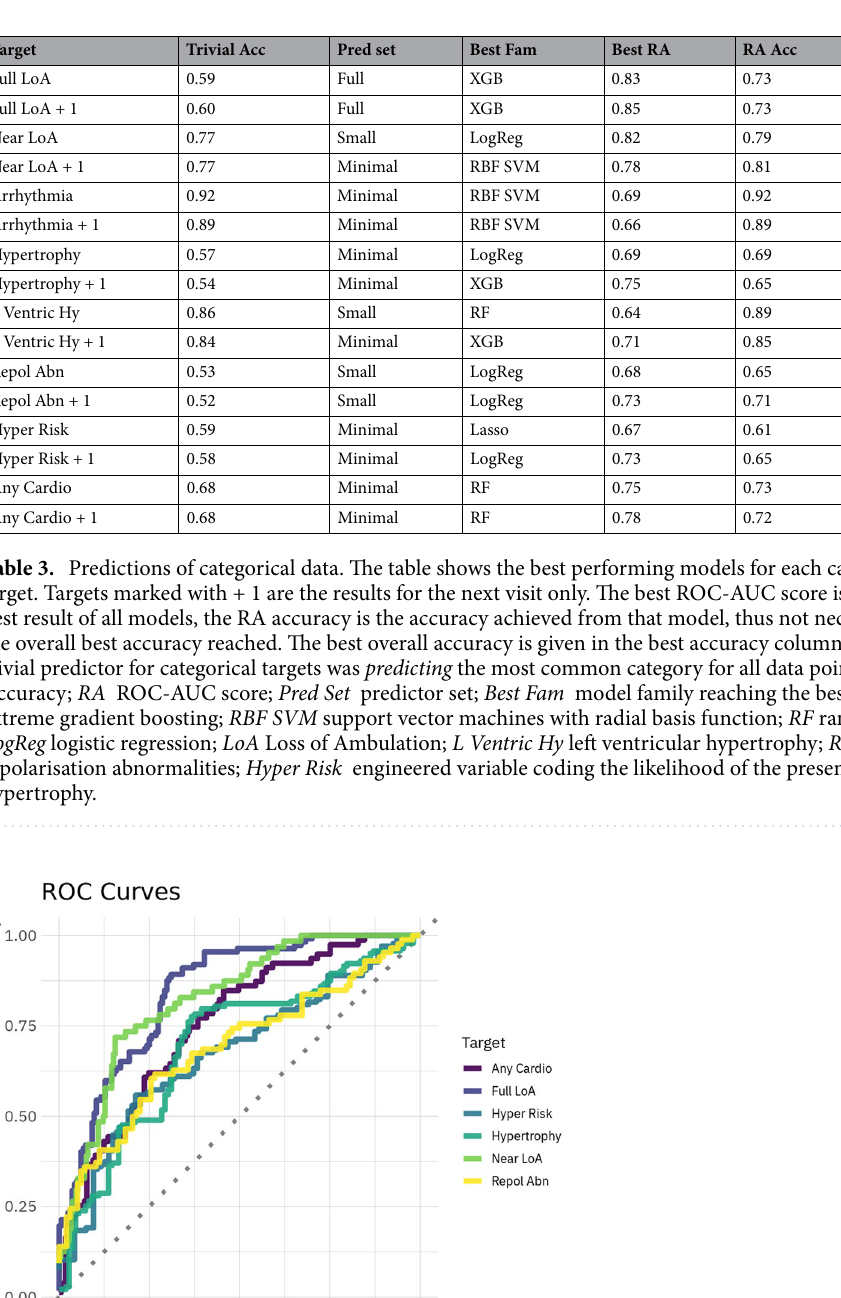
As for full loss of ambulation ROC-AUC scores where between 0.68 and 0.84, the best model having an accu- racy of 0.74 compared to the trivial classifier with 0.59. Regarding predictions for full loss of ambulation at the next visit, performance was largely similar with the model’s ROC-AUC score being 0.85, achieving an accuracy of 0.73, while the baseline was an accuracy of 0.60. Finally, for near loss of ambulation we were able to achieve ROC-AUC scores between 0.66 and 0.82. The accuracy that was reached here was 0.79, compared to 0.77 of the trivial prediction. Performance in predicting near loss of ambulation at the next visit was worse with the best ROC-AUC score being 0.78 and reaching an accuracy of 0.81, compared to 0.77 for the trivial predictor. For all details on models for categorical targets see Table 3; in addition ROC curves for selected models are visualised in Fig. 3.